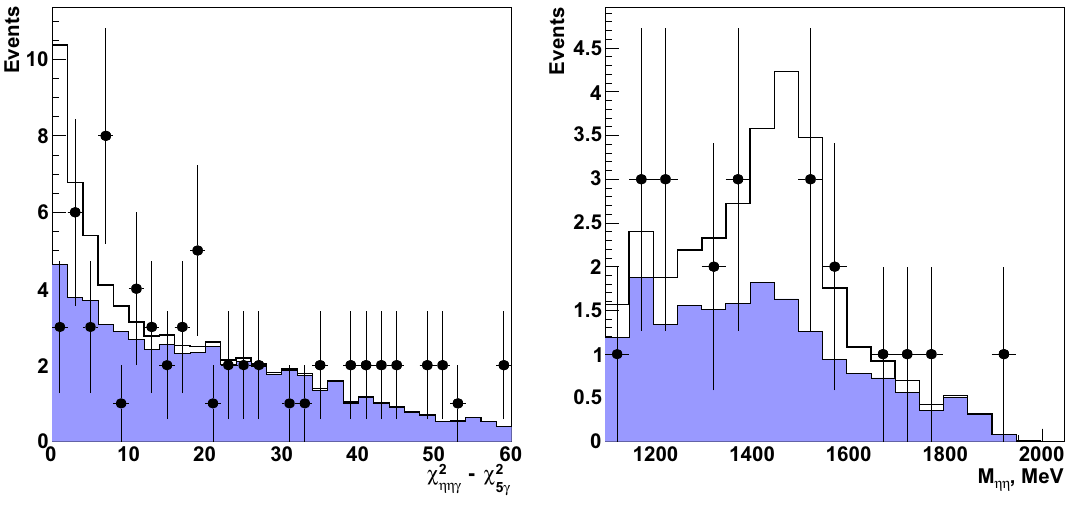
− χ 2 < 10. The shaded histogram is the expected distribution χ 2 ηηγ 5 γ for the background processes (5)–(8) and the processes (11). The solid histogram is the sum of the shaded distribution and the distribution for events of the process e + e − → f 0 ( 1500 )γ → ηηγ with a cross section of 5